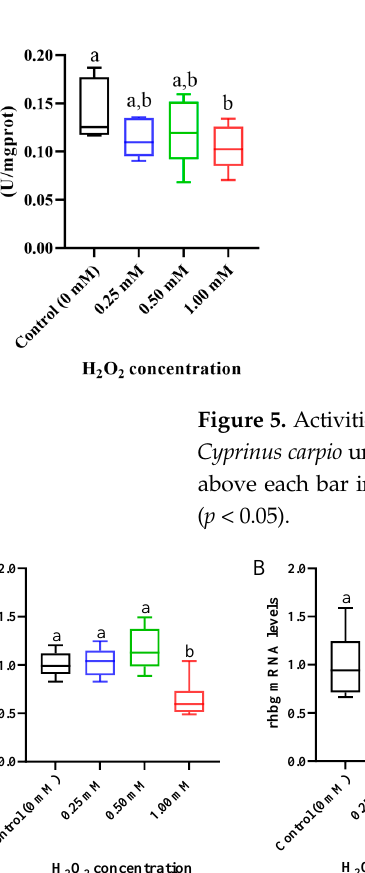
Figure 6. Expression of ion-transport-related genes in gills of Cyprinus carpio under H 2 O 2 exposure . ( A ) Sodium/potassium-transporting ATPase subunit alpha ( nkaa ); ( B ) rhesus glycoprotein B ( rhbg ); ( C ) rhesus glycoproteins C 1 ( rhcg1 ) and ( D ) rhcg2 . Data are expressed as mean ± SE (n = 9). The different letters above each bar indicate a statistical significance among different concentrations of H 2 O 2 exposure ( p < 0.05).